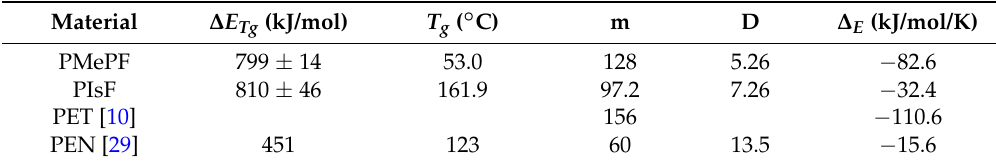
Table 2. Fragility parameters for different polymers.